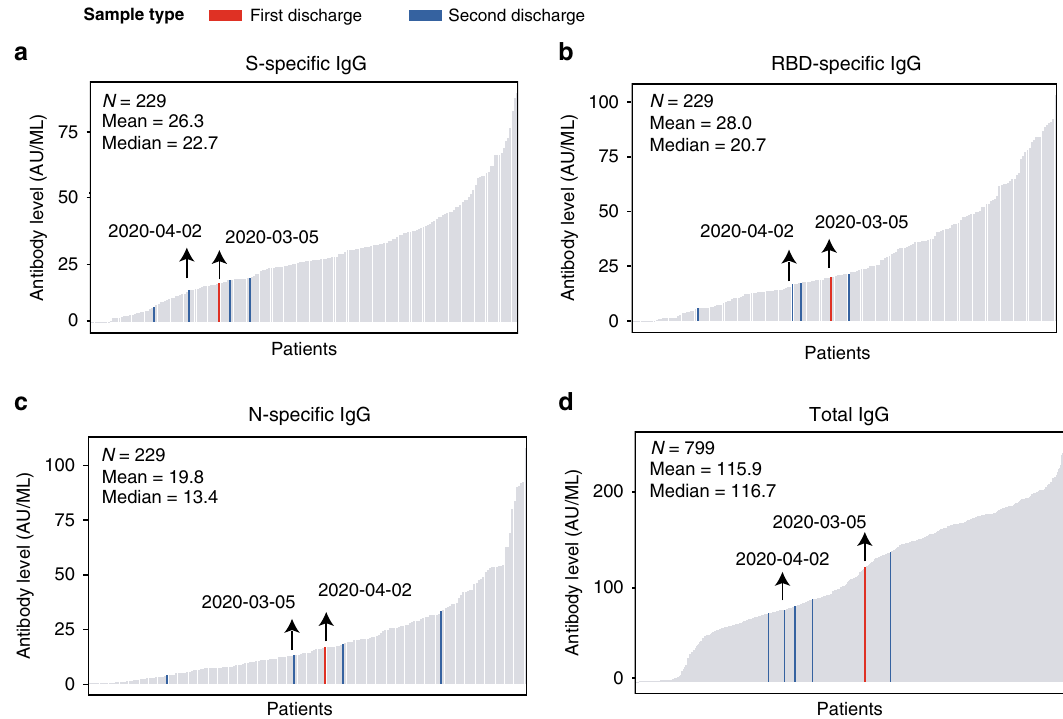
Fig. 5 Level of IgG on discharge. Barplot displays of the level of S-speci fi c ( a ), RBD-speci fi c ( b ), N-speci fi c ( c ), and total IgG ( d ) in patients on discharge. The red bar indicates the time of the fi rst discharge, and the blue bar indicates the time of the second discharge. The black arrows indicate the antibody levels of Patient